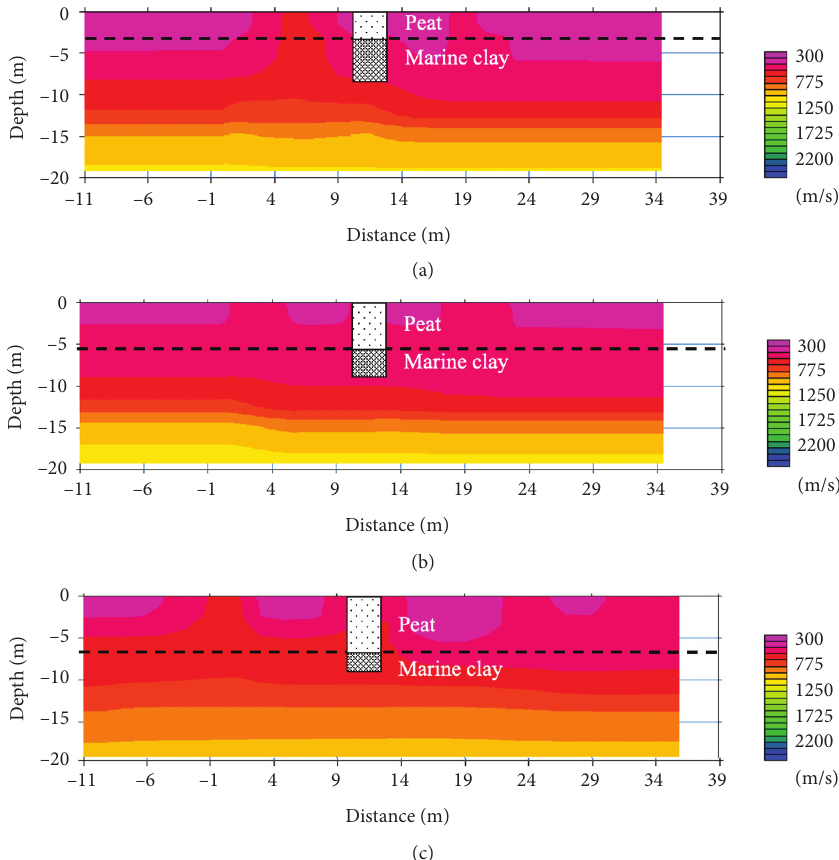
Figure 11: 2D V p images: (a) S1, (b) S2, and (c) S3.